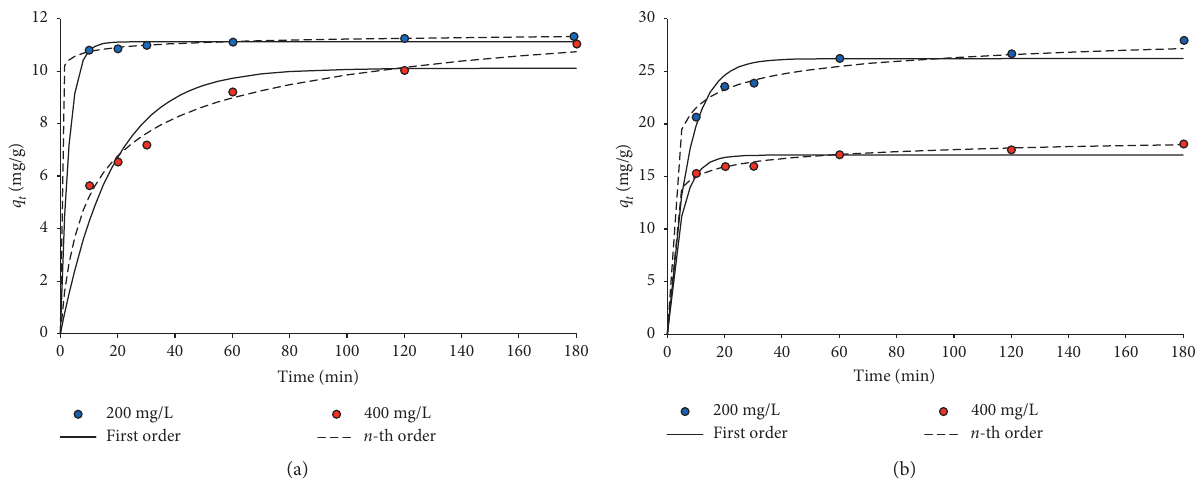
Figure 2: Kinetic model for nickel ions onto CKD particles as a result of total sorption and pure adsorption. (a) Sorption. (b) Adsorption- precipitation.